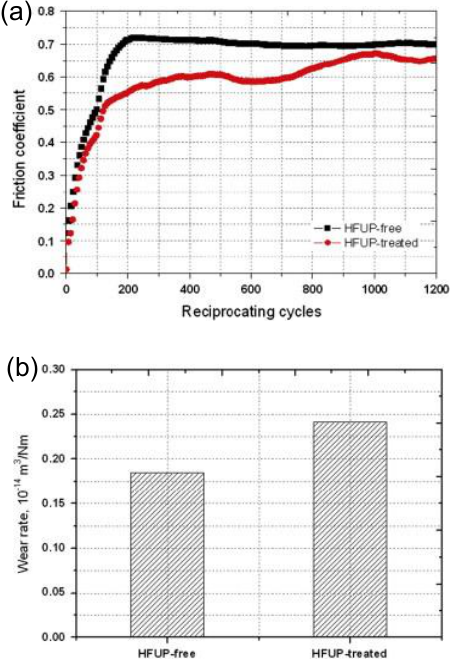
Figure 12. Comparison of average friction coefficient ( a ) wear rate ( b ) of the ball counter surfaces slid against the HFUP free and HFUP-treated specimens. Reproduced from [56], with permission from Elsevier, 2013.